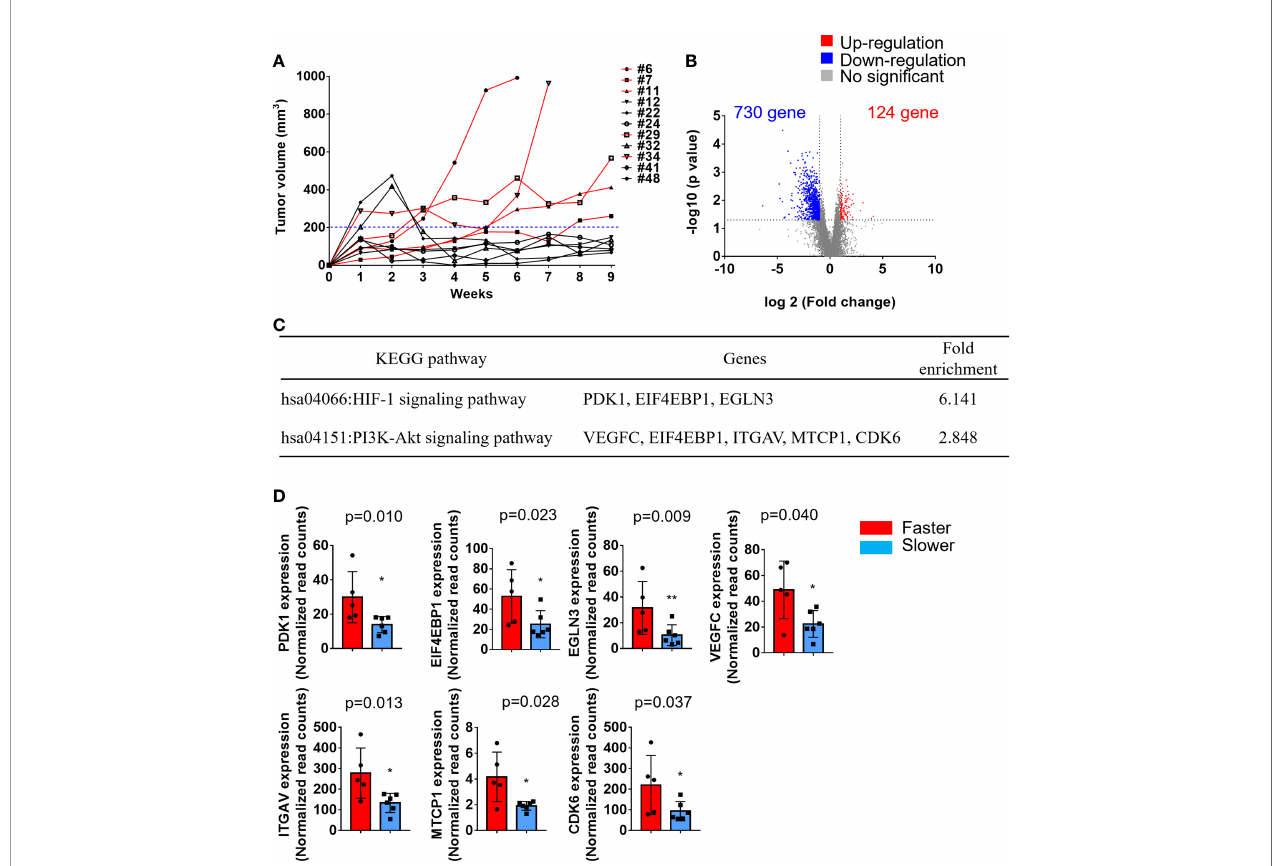
FIGURE 3 | Transcriptomic analysis of faster growing tumors compared with slower growing tumors. Primary tumors were excised and transplanted into immune- de fi cient mice. The tumor volumes in the fl anks of mice were monitored twice a week. (A) Tumor growth curve of these 11 PDXs. The patients were divided into either a faster (red lines, tumor > 200 mm 3 ) or slower (black lines, tumor < 200 mm 3 ) growing group. (B) Volcano plot displays the DEGs between faster and slower growing tumors from RNA-seq analysis. The x-axis shows the log2-fold change values, and the y-axis shows the -log10 p values for the differentially expressed genes. (C) A total of 124 upregulated and 730 downregulated genes were subjected to KEGG pathway analysis. The signi fi cantly upregulated pathways are shown. (D) The expression of PDK1, EIF4EBP1, EGLN3, VEGFC, ITGAV, MTCP1, and CDK6 was signi fi cantly upregulated in the faster growing group. The p values were calculated using the Mann – Whitney U test. The P value < 0.05 indicated statistical signi fi cance. (*p<0.05,